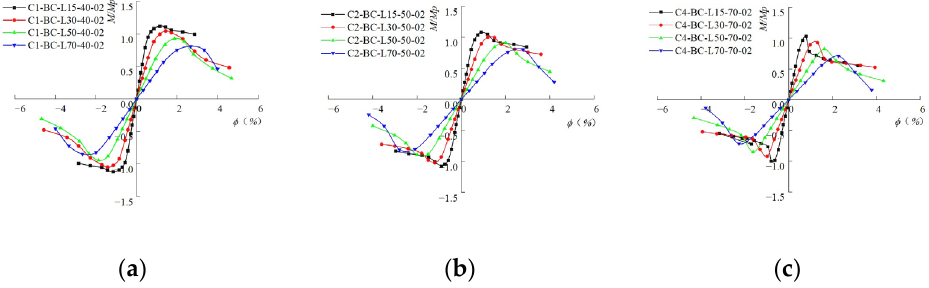
Figure 9. The slenderness ratio effect. ( a ) h / t = 40, n = 0.2; ( b ) h / t = 50, n = 0.2; ( c ) h / t = 70, n = 0.2.